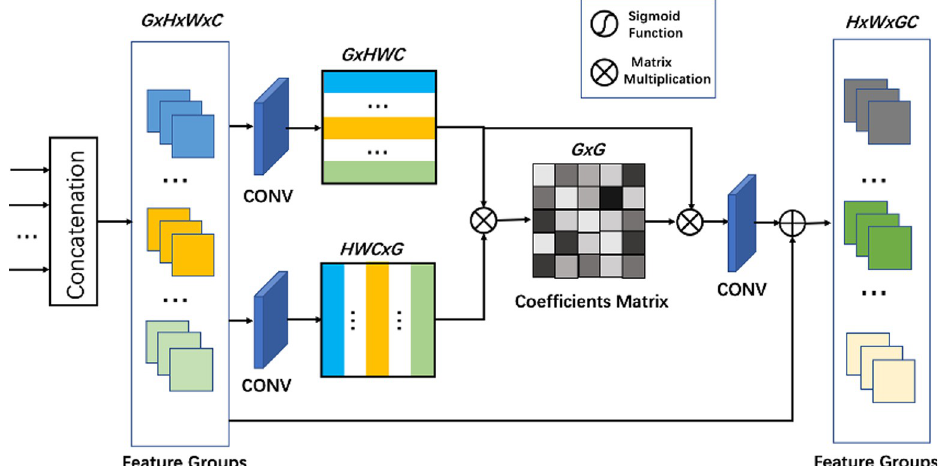
Fig 2. The structure of the proposed concatenated attention